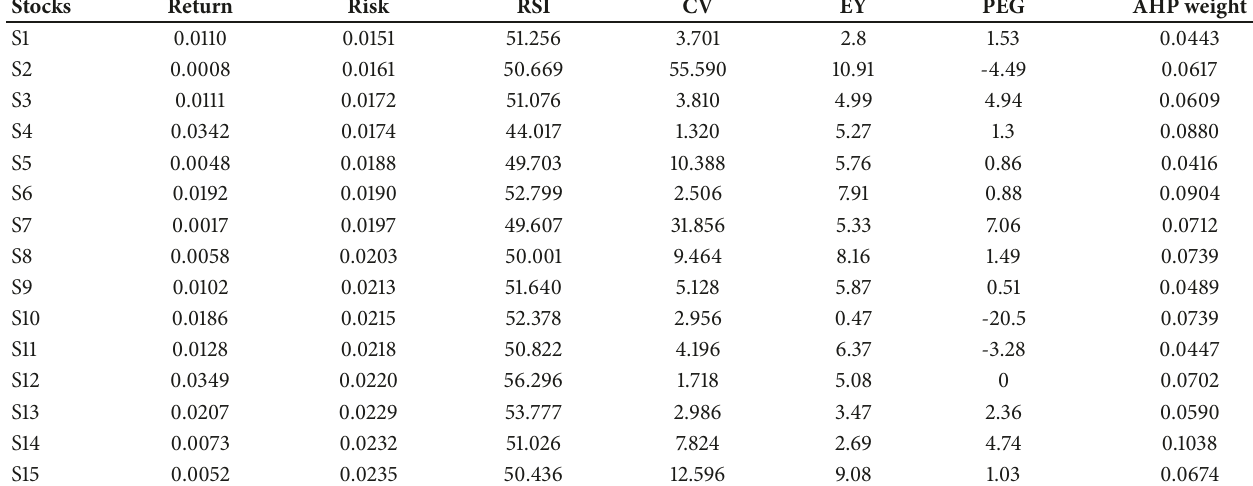
Table 5: Input data for Cluster 2.